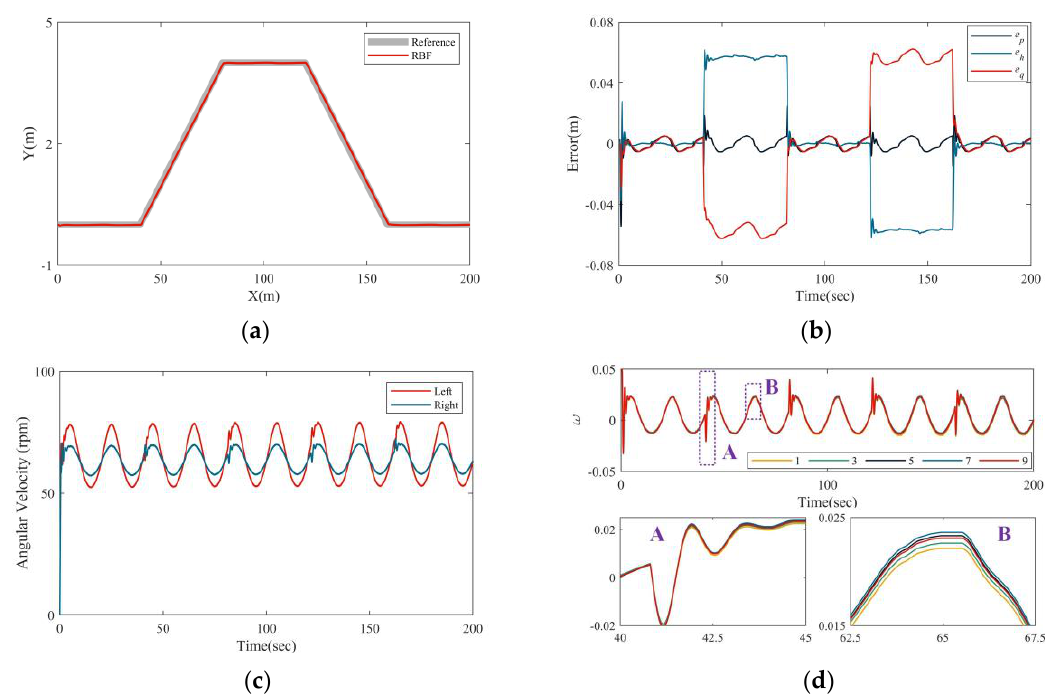
Figure 6. Tracking results of the proposed framework under a double-lane-change maneuver: ( a ) trajectory, ( b ) tracking errors, ( c ) angular velocity of the left and right driving wheels, and ( d ) weights of the RBF network.